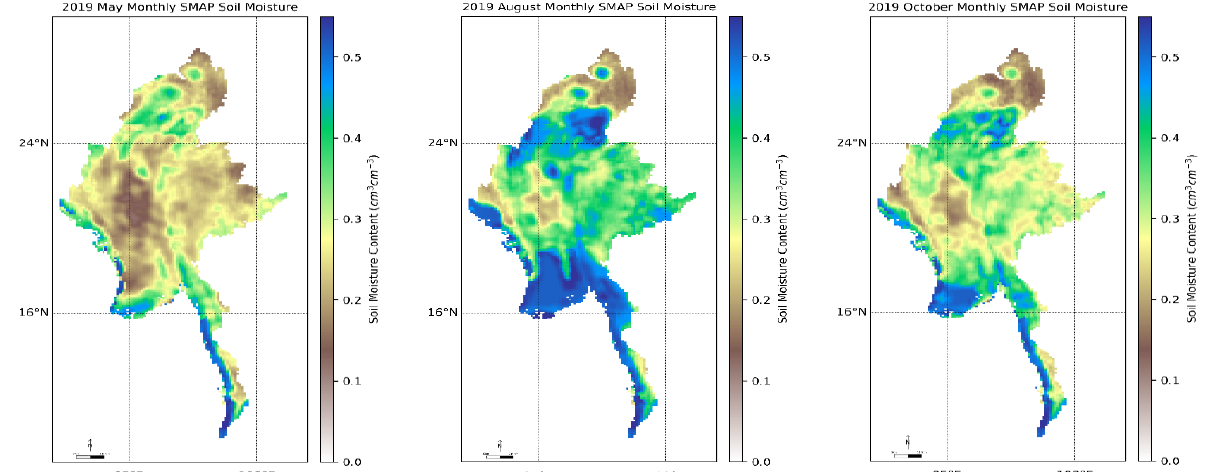
Figure 4. Monthly SM data received by the SMAP Passive Radiometer in May, August, and October 2019.